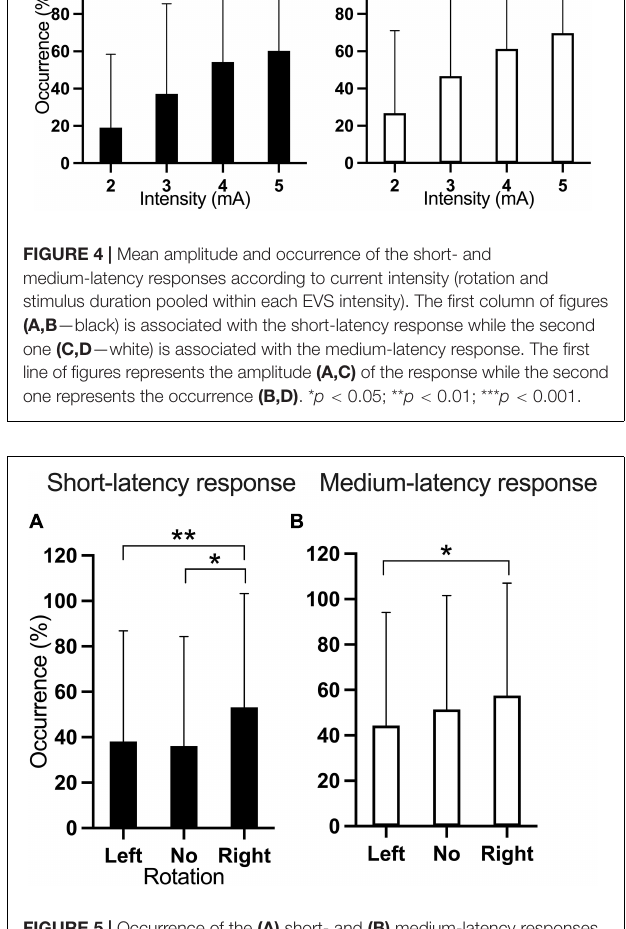
axons (Goldberg et al., 1984; Dlugaiczyk et al., 2019). Increased EVS current intensity recruits a more significant proportion of regular vestibular afferent fibers in monkeys (Goldberg et